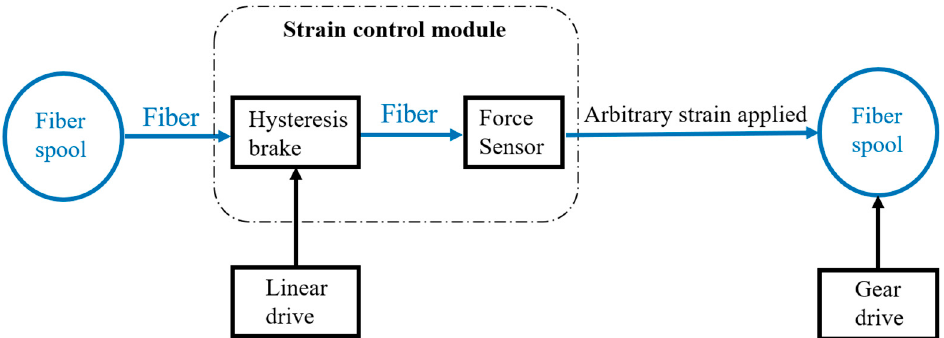
Figure 11. Schematic of the fiber coiling machine.